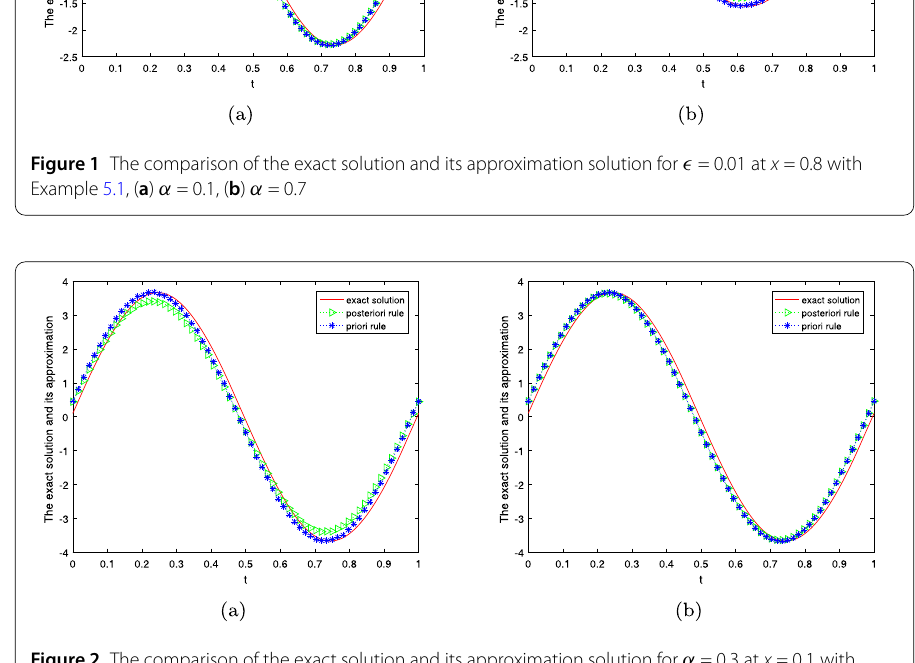
Figure 2 The comparison of the exact solution and its approximation solution for α = 0.3 at x = 0.1 with Example 5.1, ( a ) (cid:13) = 0.01, ( b ) (cid:13) = 0.001